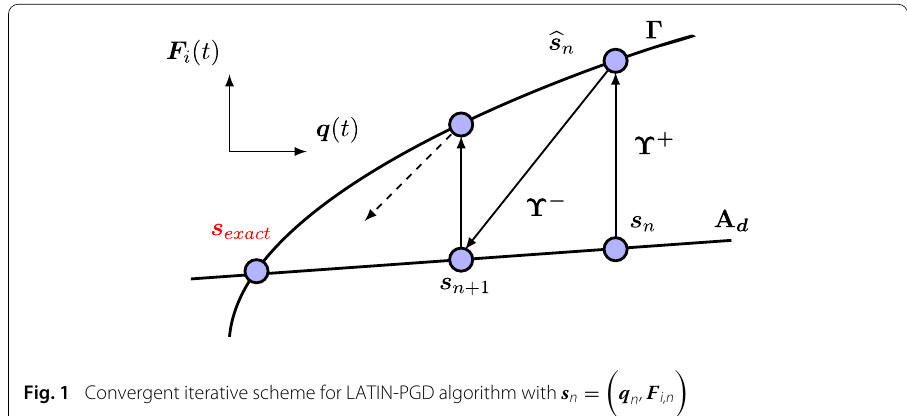
Fig. 1 Convergent iterative scheme for LATIN-PGD algorithm with s n =